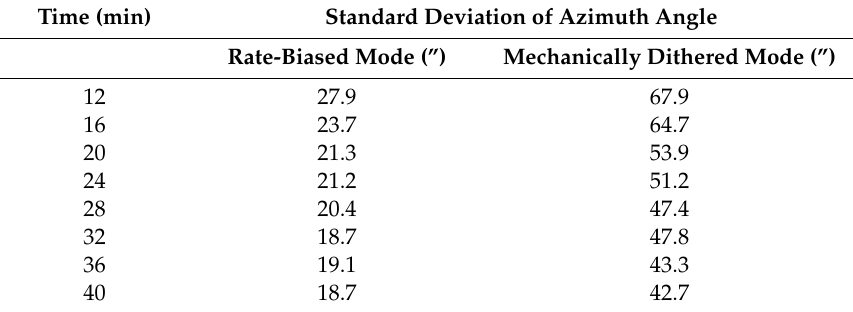
Table 7. Results of alignment experiments.